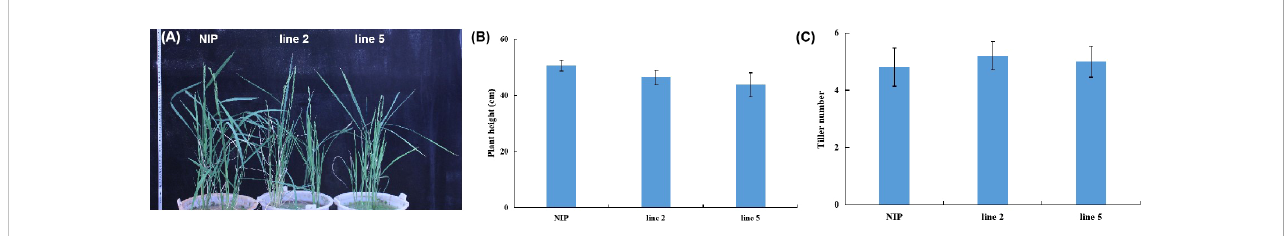
FIGURE 2 Morphology of plants of the knock-out mutants of Osv-ATPase d and the wild type. (A) Plants at 60 days of age. (B) Plant height; (C) Tiller number.